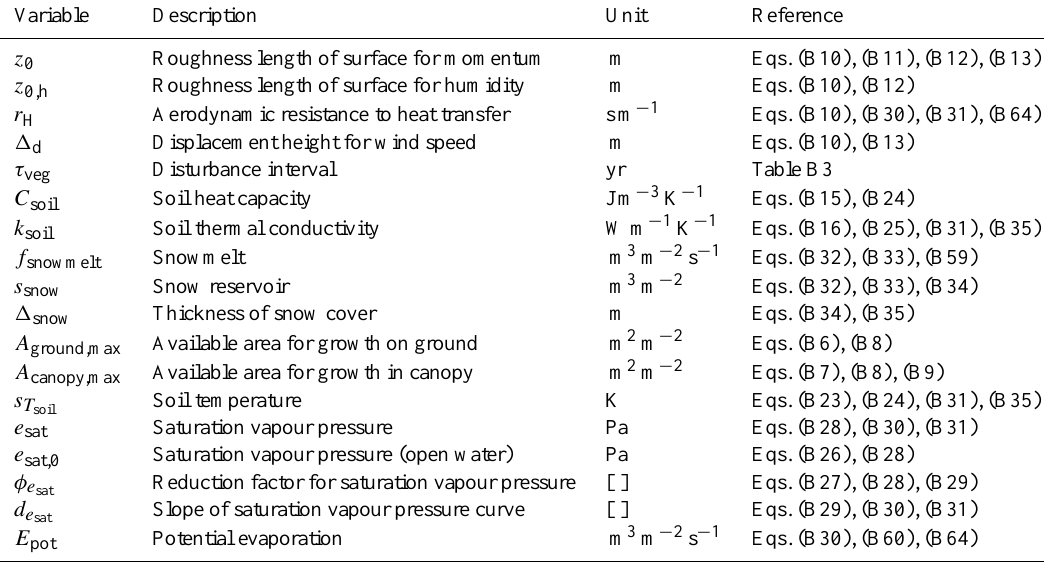
Table B13. Variables associated with the environment.